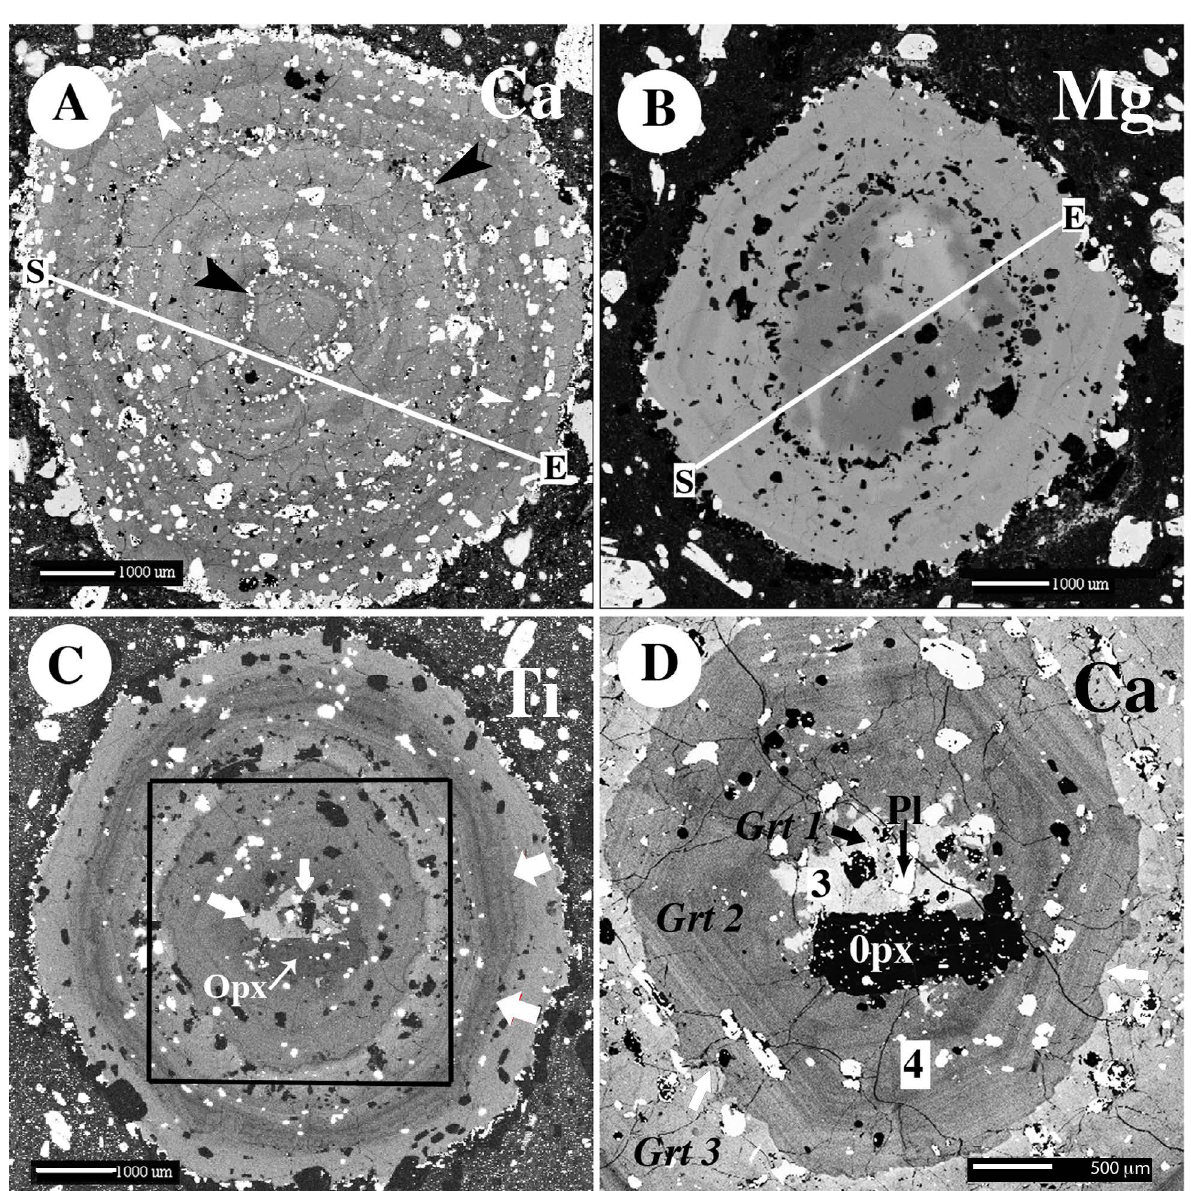
Figure 6: Representative examples of garnet megacrysts. All images are X-ray element maps (Ca, Mg, Ti) in grey scales, adjusted to highlight the differences in composition from one ring to another. Lighter grey represents higher and darker grey lower concentrations for a selected element; the relative intensity scales are different for each map. Numbered spots in white squares refer to garnet analyses in Table 6. Cross-sections labelled SE in panels [A] and [B] correspond to line profiles of analyses (S for start, E for end) given in Figure 8. [A] Ca X-ray image of a common garnet type. Two concentric rings (black arrows) richer in plagioclase inclusions (white) suggest the existence of periods of more rapid growth of the host-garnet, while the scalloped limit in the outer ring (white arrows) underlines an inconspicuous dissolution episode. Note the narrowness of the plagioclase reaction-rim. [B] Mg X-ray image of a rounded garnet megacryst. Regular circular zoning in the outer ring (light grey) testifies for continuous garnet growth without major resorption episodes. Plagioclase inclusions (black) outline the core (dark grey). The light grey pool inside the core is interpreted as evidence of inward corrosion by the Mg-richer external ring. [C] : Ti X-ray image of one of the composite garnets cited in the text. In the outer ring, a slight oscillatory zoning (white arrows) clearly shows the euhedral character of the growing faces. Black arrows outline the corrosion of the central nucleus. [D] Ca X-ray image of the boxed area in Figure 7C. Mineral abbreviations after Whitney and Evans [2010]. The strongly corroded central nucleus (Opx ` Grt 1 ` Pl) is overgrown by a euhedral, oscillatory zoned rind (Grt 2). These well-faceted layers (25 to 150 microns wide) are then sharply truncated by a dissolution surface (white arrows) and mantled by a Ca-richer garnet (Grt